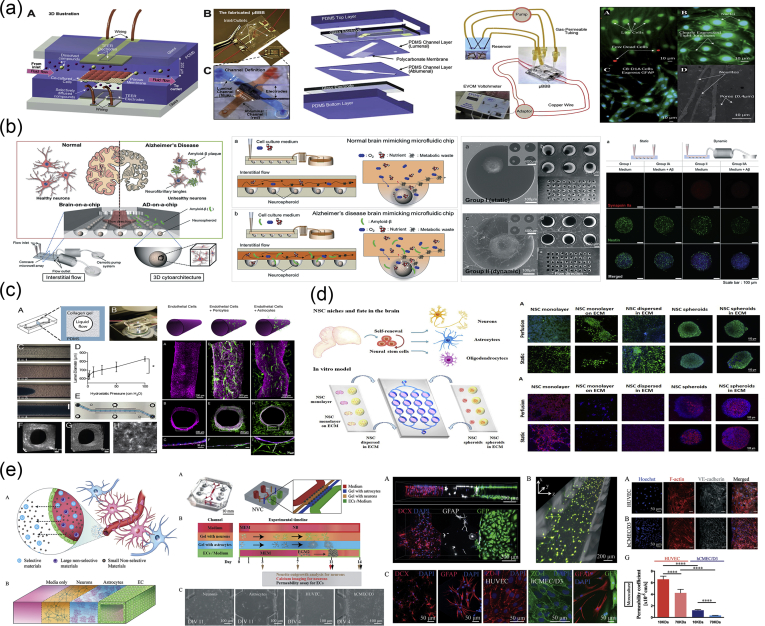
Use of soft lithography for the fabrication of lab-on-a-chip devices for neuronal applications. (a) A microfluidic device mimicking the natural BBB [210], (b) a brain-on-a-chip as the in vitro model of Alzheimer'’s ​disease [212], (c) a 3D human BBB-on-a-chip as the in vitro model for neurovascular inflammation [213], (d) a microfluidic chip for studying neural stem cell fate determination [214], and (e) a 3D neurovascular microfluidic system as a model for BBB [215]. Images adapted with permission from (a) Booth and Kim [210], (b) Park et al. [212], (c) Herland et al. [213], (d) Wang et al. [214], and (e) Adriani et al. [215]. BBB, blood-brain barrier; μBBB, microfluidic BBB; PDMS, polydimethylsiloxane; NSC, neural stem cell; ECM, extracellular matrix; 3D, three-dimensional; HUVEC, human umbilical vein endothelial cells; hCMEC/D3, human cerebral microvascular endothelial cells; AD, Alzheimer's Disease.